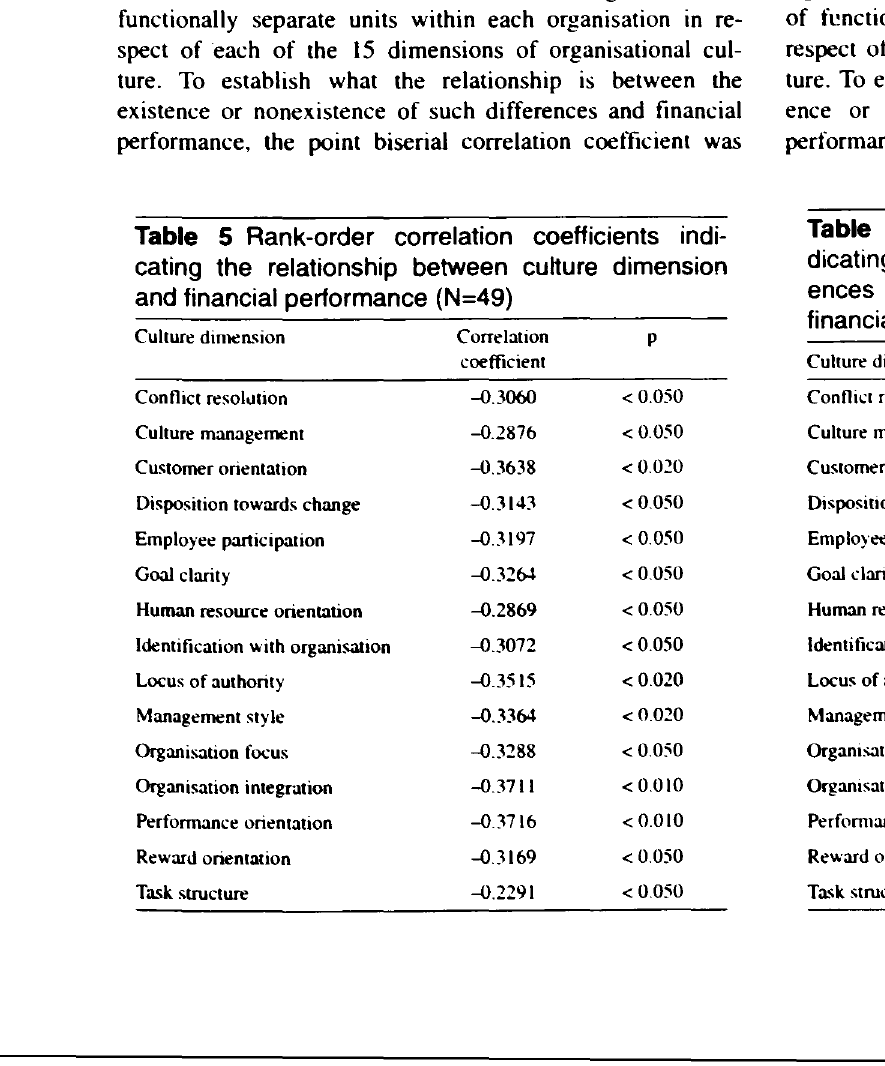
Table 5 Rank-order correlation coefficients indi cating the relationship between culture dimension and financial performance (N=49)